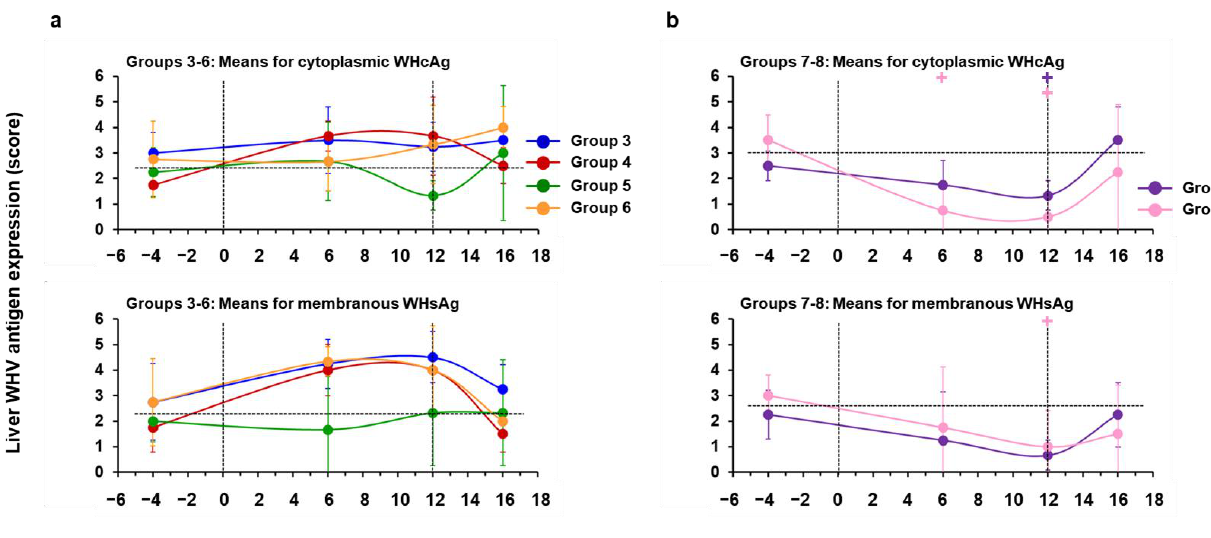
Figure 10. hzVSF does not reduce antigen expression in the liver, but suppression is pronounced in combination with TAF. Comparison of mean scores of ( a ) Groups 3–6 treated with placebo or hzVSF at a low, intermediate, and high dose and ( b ) Groups 7–8 treated with TAF, alone or in combination with hzVSF at an intermediate dose, relative to the pretreatment baseline (week − 4) for cytoplasmic WHcAg and membranous WHsAg expression in liver. Vertical lines indicate the standard error of the mean. Horizontal dotted lines present the mean WHV antigen expression score of Groups 3–6 or Groups 7–8 at baseline. WHcAg in Group 7 and Group 8 was significantly reduced compared to the baseline at week 12 or at weeks 6 and 12, respectively (+: p <0.05). Compared to the baseline, WHsAg in Group 8 was significantly reduced at week 12 (+: p < 0.05). Score: 0 = 0%, 1 = 1–20%, 2 = 21–40%, 3 = 41–60%, 4 = 61–80%, and 5 = 81–100% of hepatocytes expressed WHcAg or